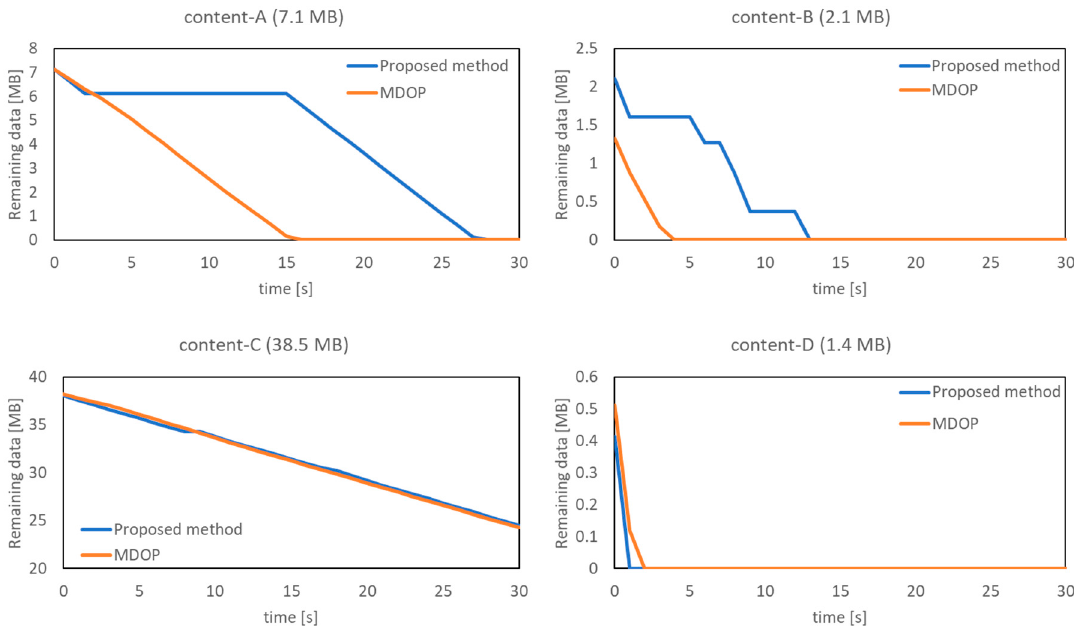
Figure 10. Trend of data remaining amount by contents.